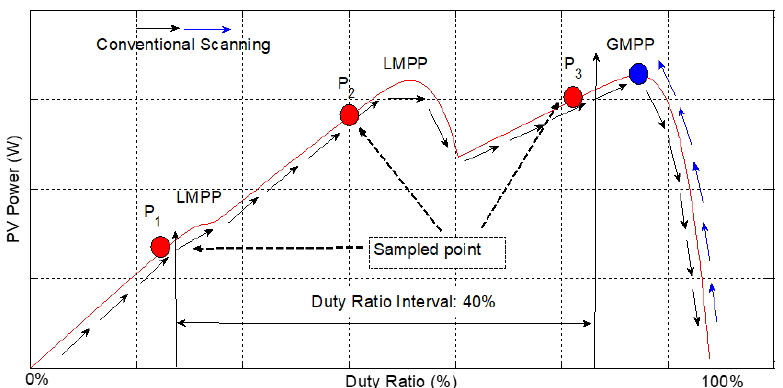
Figure 19. Duty ratio scanning approaches.